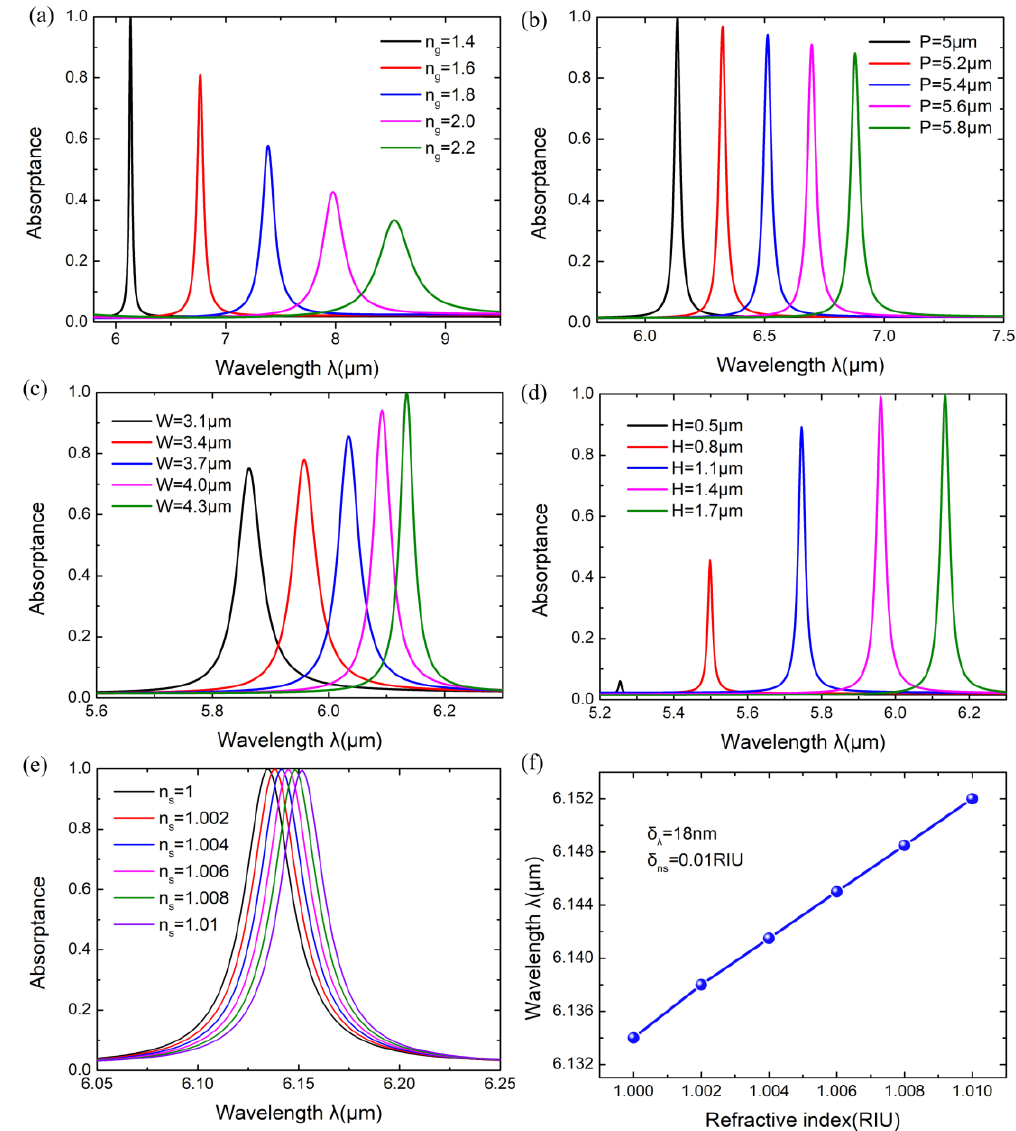
Figure 3. (a) Absorption spectra of the absorber with varying RI (n g ) of dielectric grating strips. (b) Absorption spectra with varying P when W = 4.3 µ m and H = 1.7 µ m. (c) Absorption spectra with varying W when P = 5 µ m and H = 1.7 µ m. (d) Absorption spectra with varying H when P = 5 µ m and W = 4.3 µ m. (e) Absorption spectra with di ff erent refractive index of the surrounding environment (n s ). (f) Resonant wavelength plotted as a function of refractive index n s . The parameters of the dielectric grating strips are P = 5 µ m, W = 4.3 µ m, H = 1.7 µ m, n g = 1.4.